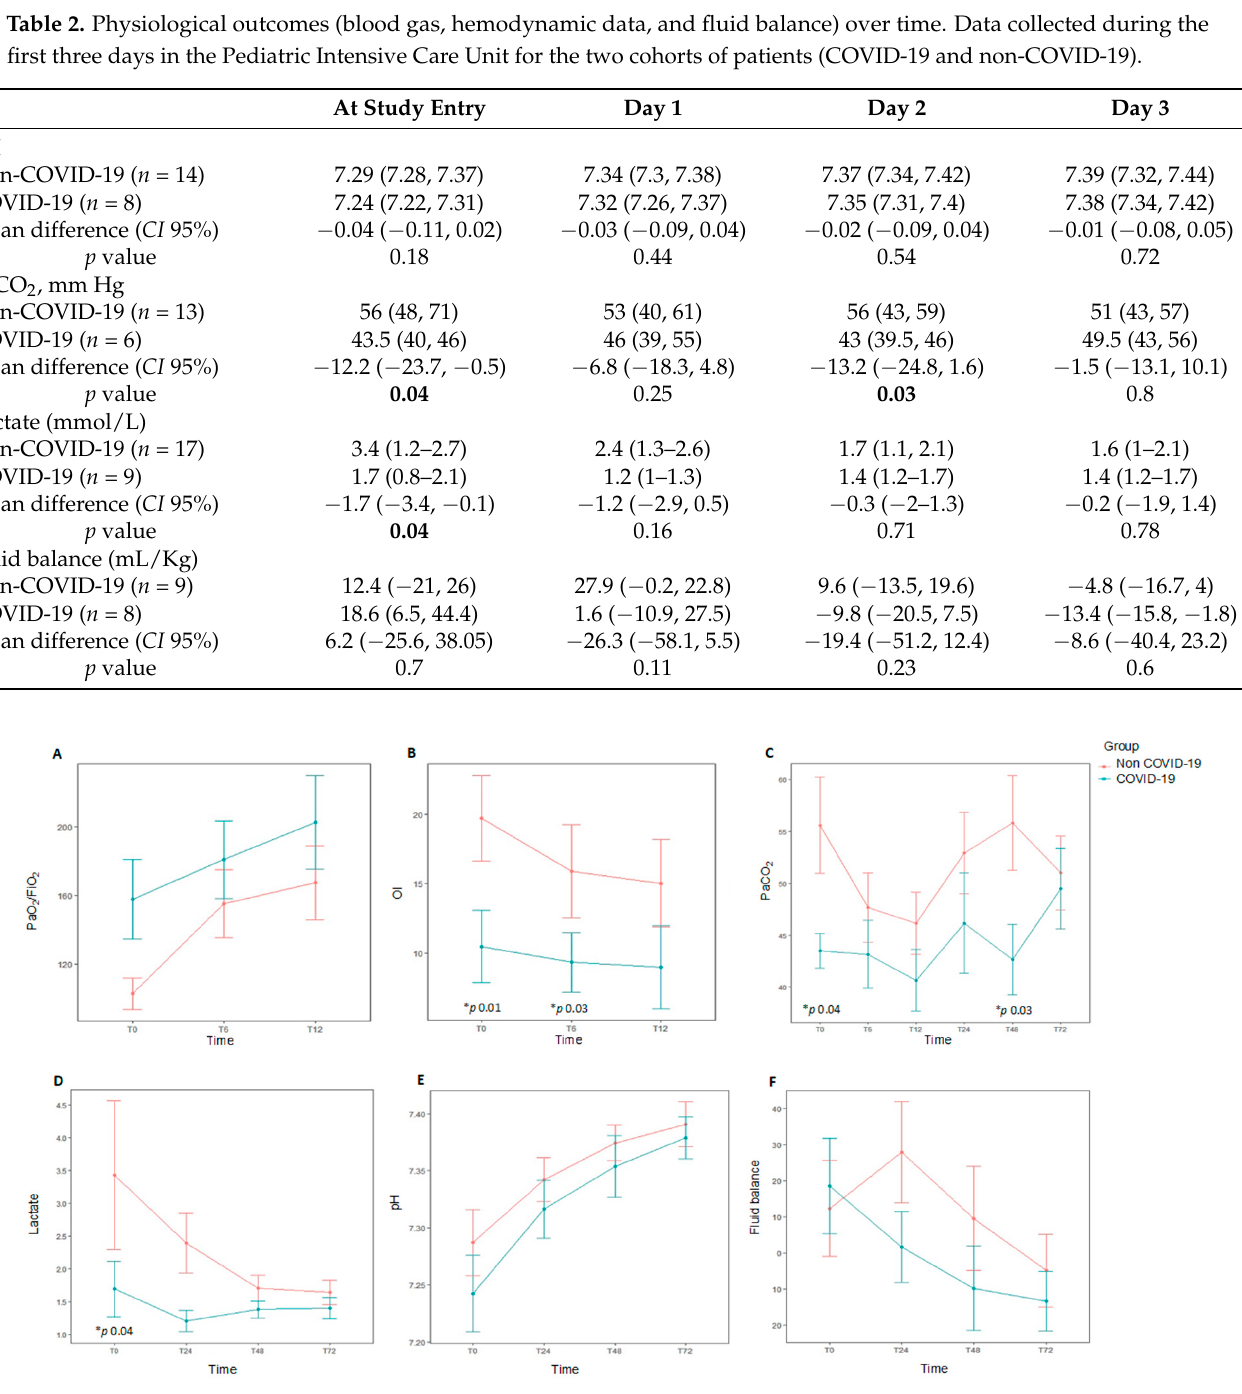
Figure 2. Data at different time points over the first 72 h for each study group comparing subjects diagnosed with acute hypoxemic respiratory failure (AHRF) and COVID-19 infection ( n = 9) to those with ARHF without COVID-19 infection ( n = 19). * p value representing statistical significance. Top: Oxygenation metrics over the 12 first hours after onset of AHRF, and daily ventilation metrics over the first 72 h of AHRF. ( A ). PaO 2 /FiO 2 ratio. ( B ). Oxygenation index (OI). ( C ). PaCO 2 . Bottom: Daily hemodynamic/metabolic data over the first 72 h for subjects diagnosed with AHRF with COVID-19 infection. ( D ). Lactate ( E ). pH. ( F ). Fluid balance. Oygenation index: FiO 2 × median airway pressure × 100/PaO 2